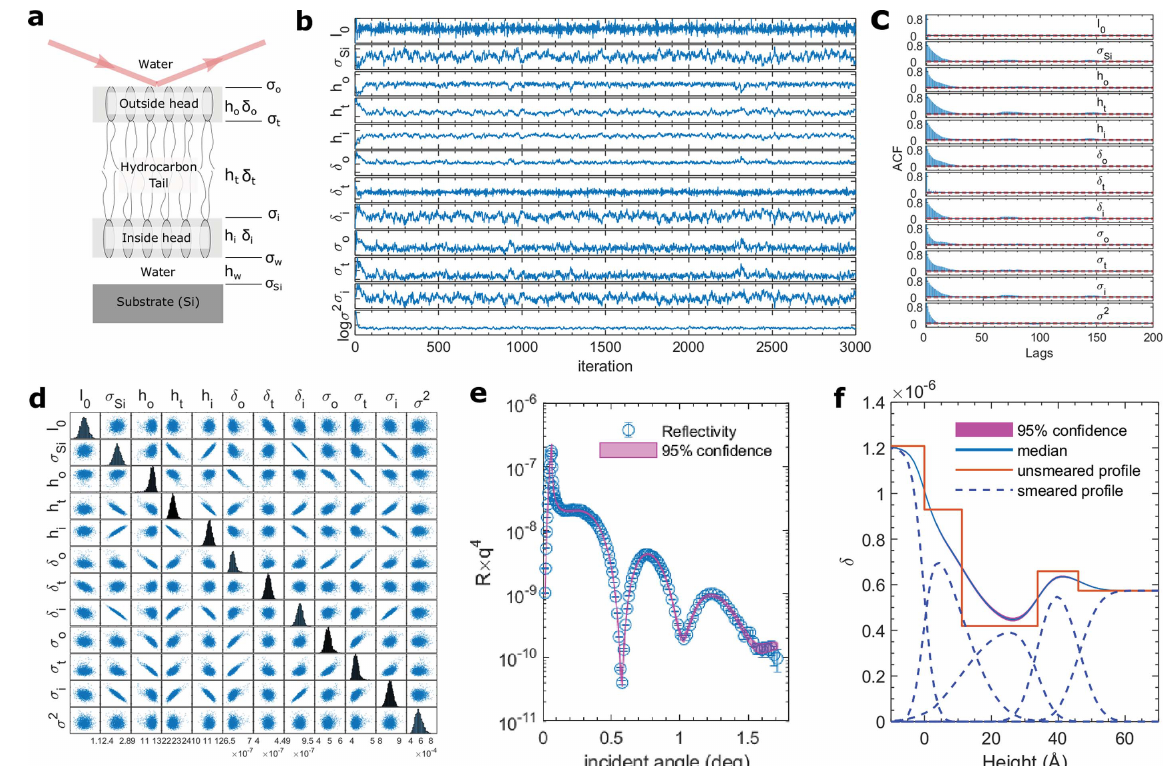
Figure 4 ( a ) Illustration of the reflectivity geometry and the layer parameters in the model. h o,t,i,w and (cid:8) o,t,i,w are layer thicknesses and dispersions; (cid:3) o,t,i,w,Si are interface roughnesses; and I 0 is the incident flux ( i.e. an intensity scale factor of the reflectivity). ( b ) Traces of parameters from HMCMC. ( c ) ACFs of parameters after 100-iteration burn-in. ( d ) Probability distributions of parameters. The off-diagonal panels are joint distributions, and the histograms along the diagonal are marginal distributions. ( e ) Reflectivity R and its 95% confidence from post-burn-in HMCMC samplings. For clarify, the reflectivity is scaled by a factor q 4 , where q = ð 4 (cid:4)=(cid:9) Þ sin (cid:11) , (cid:9) is the X-ray wavelength, and (cid:11) i is the incident angle for the reflectivity scan. ( f ) 95% confidence of the i dispersion profile. The solid blue line is the median (50%) profile. The red solid line is the step-like profile without roughness smearing. The blue dashed lines are profiles of each layer with